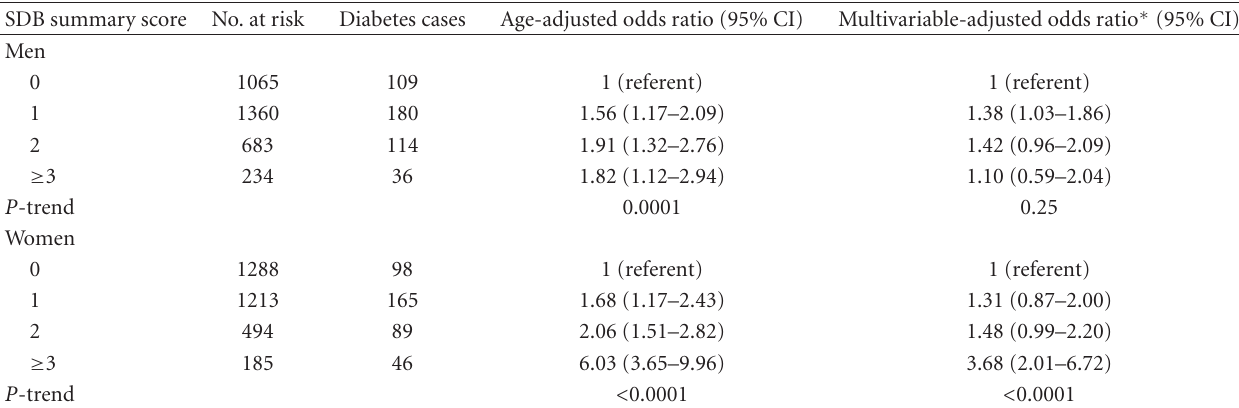
Table 4: Association between SDB and diabetes mellitus, by